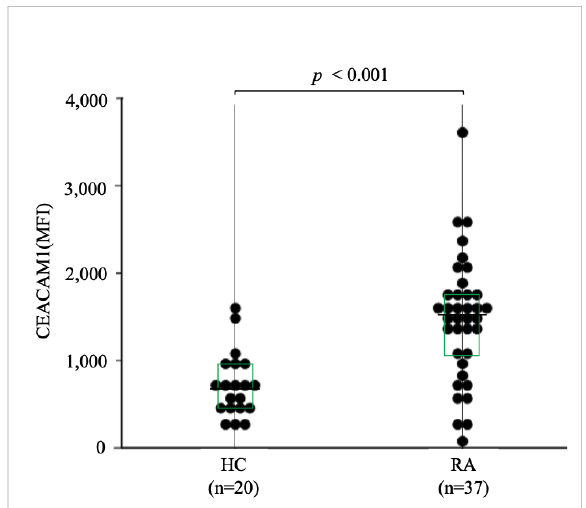
FIGURE 2 The expression of CEACAM1 on peripheral blood neutrophils isolated from HC (n=20) and RA patients (n=37). The MFI of CEACAM1 in RA patients was signi fi cantly higher compared to those in HC. Statistical signi fi cance was determined by the Mann – Whitney U test. Horizontal bars and squares indicate median and IQR, respectively. HC, healthy controls; RA, rheumatoid arthritis; MFI, mean fl uorescence intensity; IQR, interquartile